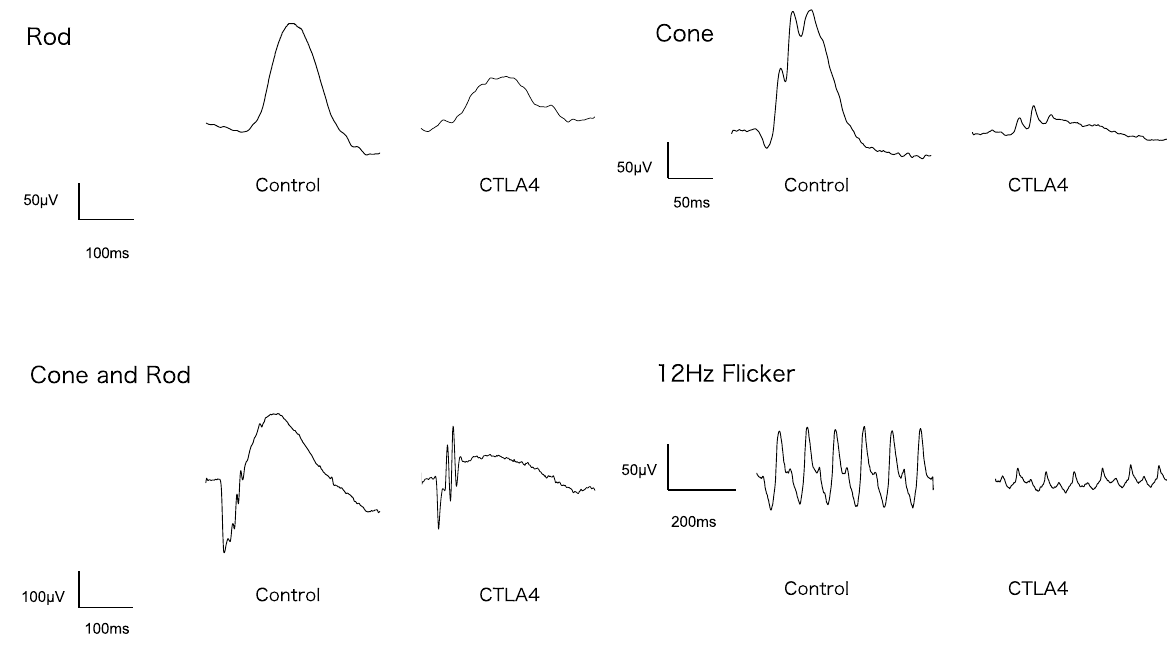
Figure 9. Representative a-wave, b-wave, cone, and 12-Hz flicker responses for control and treated eyes. For all waves, the amplitudes were lower for treated eyes than for control eyes. Despite the lower amplitudes, wave forms were preserved (n = 5 in each